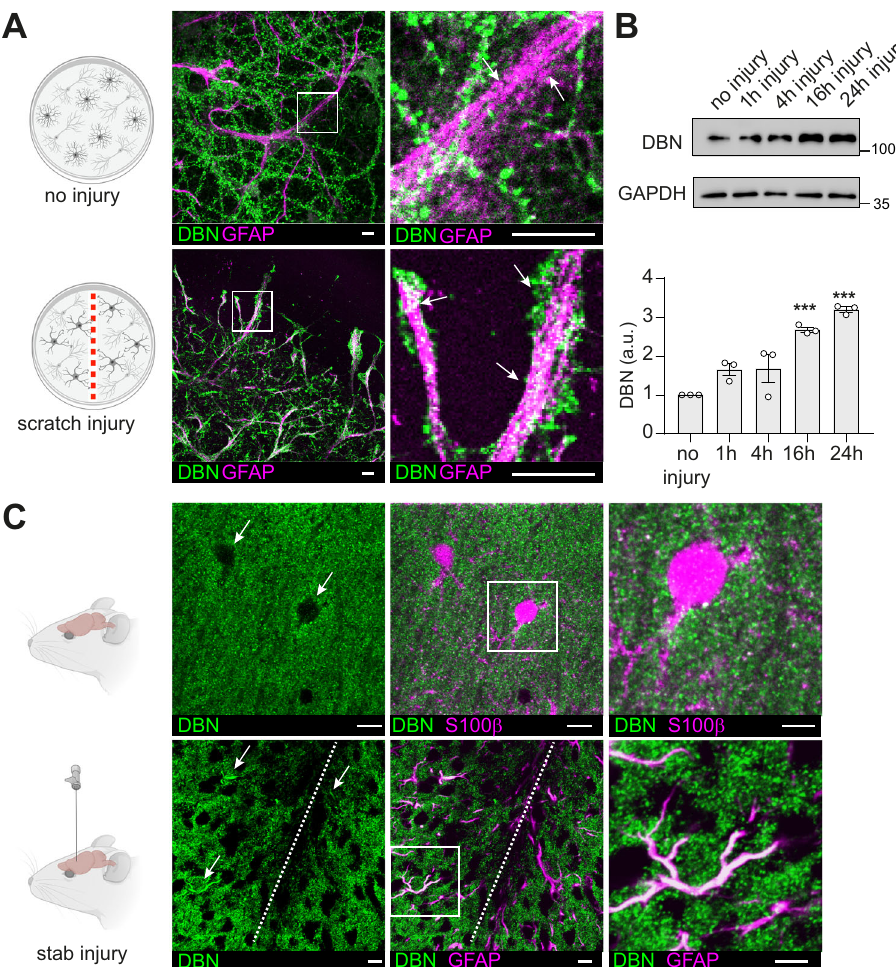
Fig. 1 DBN protein levels are increased in response to injury. A DBN labeling (green) in mixed 21 DIV cortical cultures without (upper panels) or with mechanical scratch injury (lower panels). Square in the left image is magni fi ed on the right. Arrows show GFAP + astrocyte processes, devoid of DBN (upper panel) and with strong DBN signals following scratch injury (lower panel). Representative image of three independent experiments. Scale bars: 10 µ m. B DBN expression analyses by western blotting in enriched astrocyte cultures without, or 1, 4, 16, and 24 h after scratch injury. Quanti fi cation of protein levels showing mean, individual data points and SEM; n = 3 independent experiments, (one-way ANOVA F = 23.39; DFn = 4, DFd = 10, Dunnett ’ s multiple comparisons test *** P < 0.001; multiplicity adjusted p values: no injury vs 16 h: P = 0.0003; no injury vs 24 h: P = 0.0001). C Sections of P30 mouse brains without (upper panels) or with stab injury (lower panels) were labeled with anti-DBN (green) and anti-S100 β (upper panel, magenta) or anti- GFAP (bottom panel, magenta). Arrows show astrocytes devoid of DBN (upper panel) and with DBN protein following stab injury (lower panel). Scale bars: 10 µ m. Magni fi cations on the right show no or high expression of DBN in S100ß + or GFAP + astrocytes in brains with or without stab injury, respectively. Representative image of two animals, three brain slices/animal. Scale bars: 20 µ m. All confocal images in this fi gure are single optical sections. Source data are provided as a Source Data fi